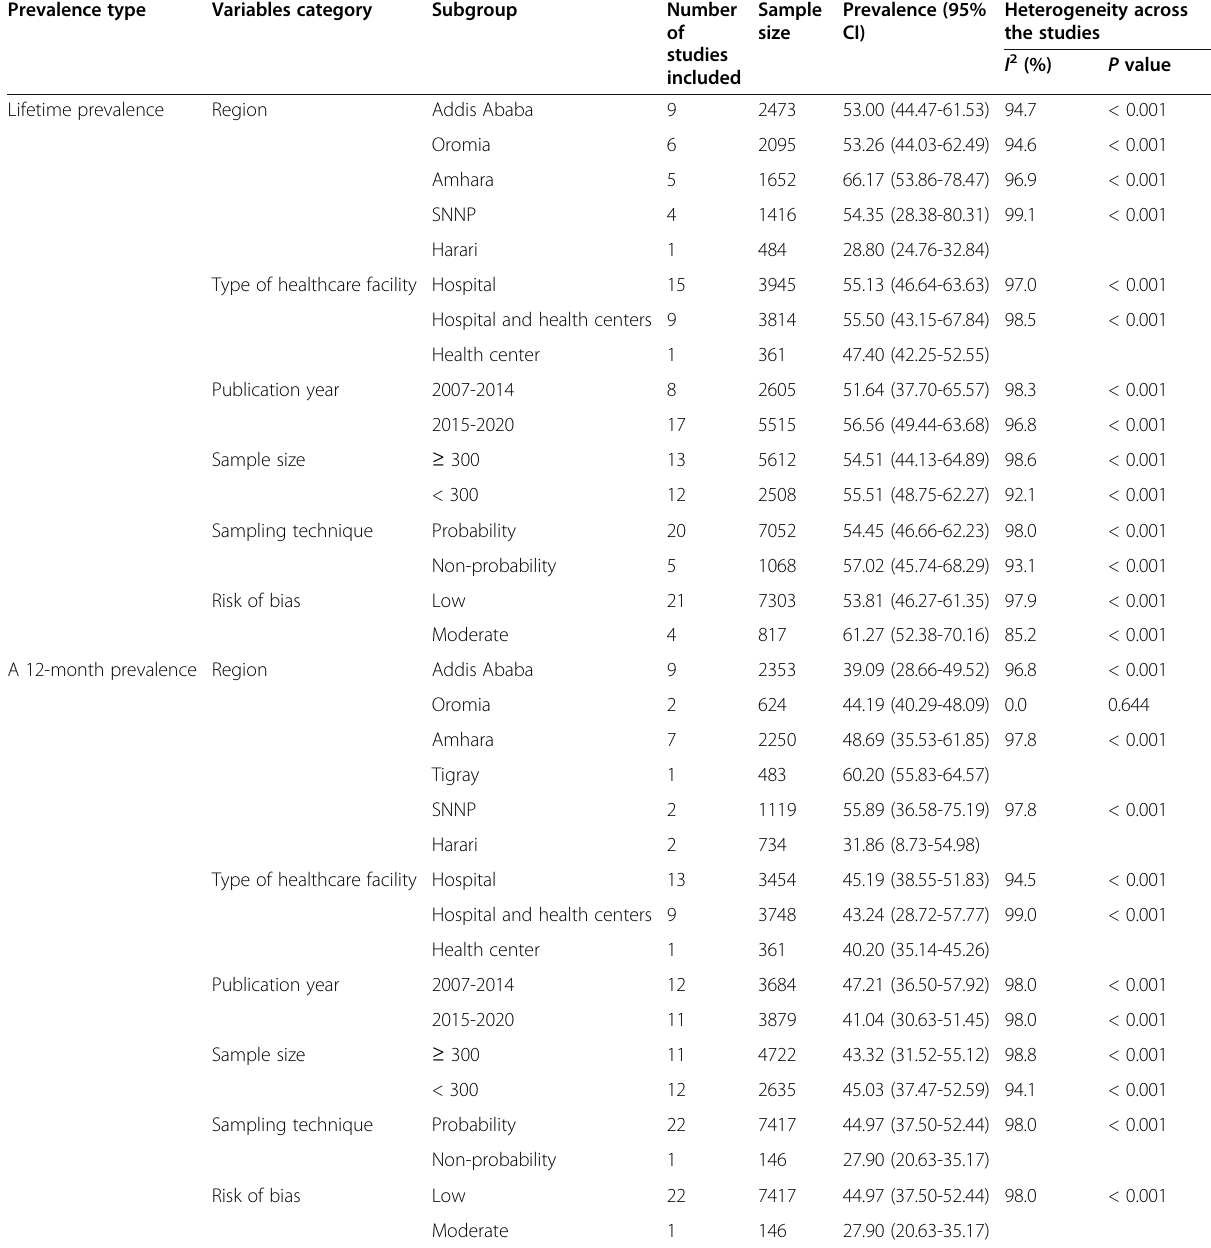
Table 2 Subgroup meta-analysis, blood and body fluid exposure among healthcare workers in Ethiopia, 2007 – 2020 Prevalence